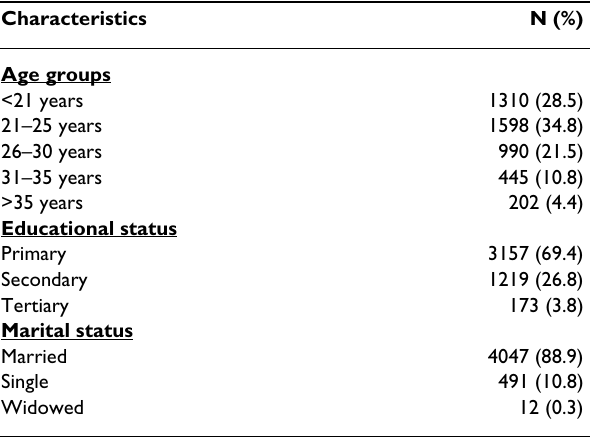
Table 1: Socio-demographic characteristics among antenatal attendees Characteristics N (%) Age groups